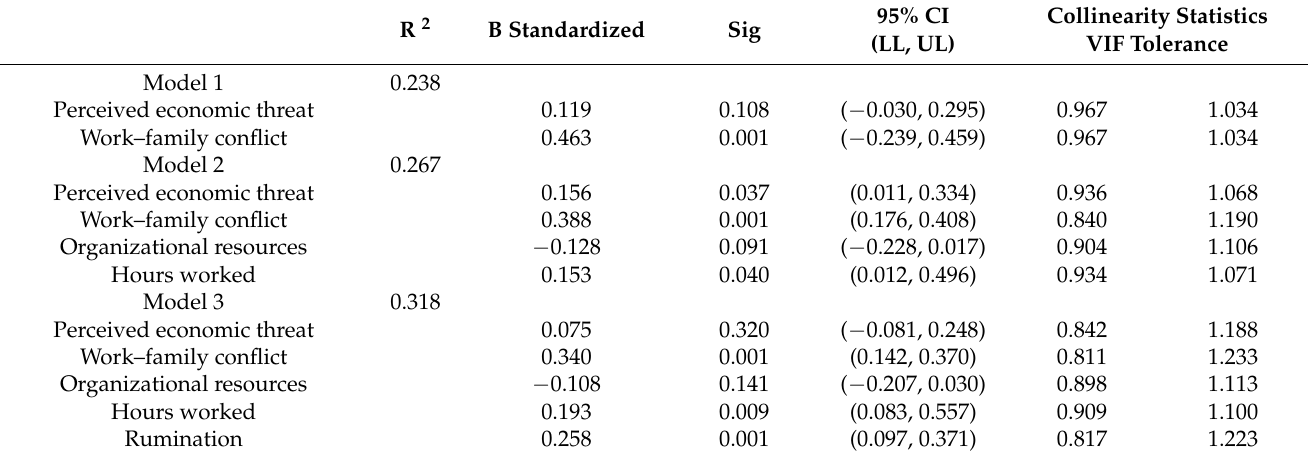
Table 3. Hierarchical regression on work-related stress among teleworkers.